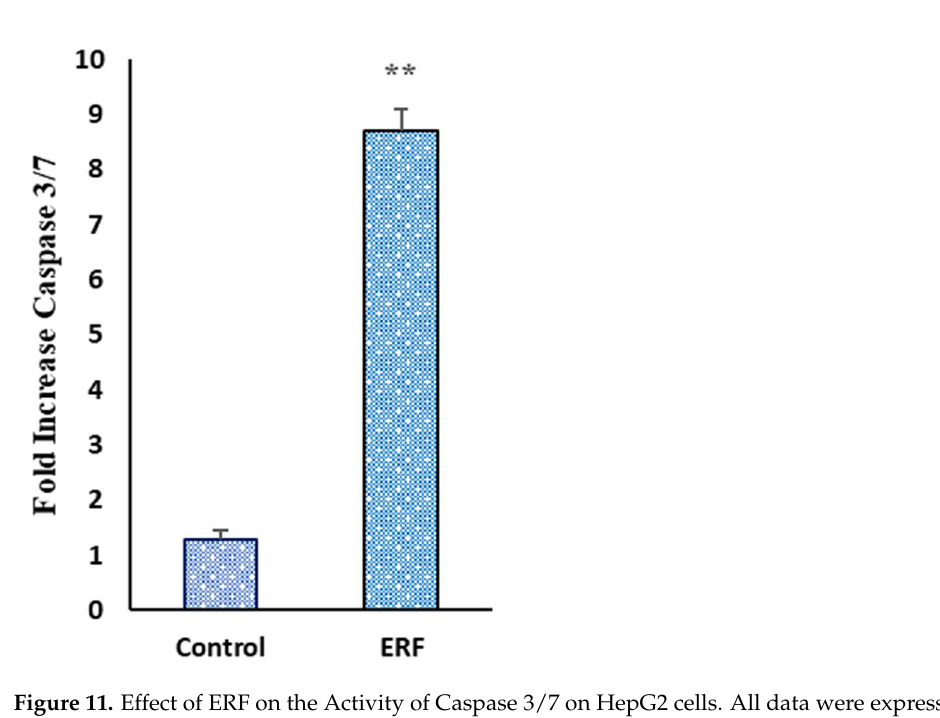
Figure 11. Effect of ERF on the Activity of Caspase 3/7 on HepG2 cells. All data were expressed as mean ± standard deviation (SD) at a significance level of p < 0.05 and indicated by **.